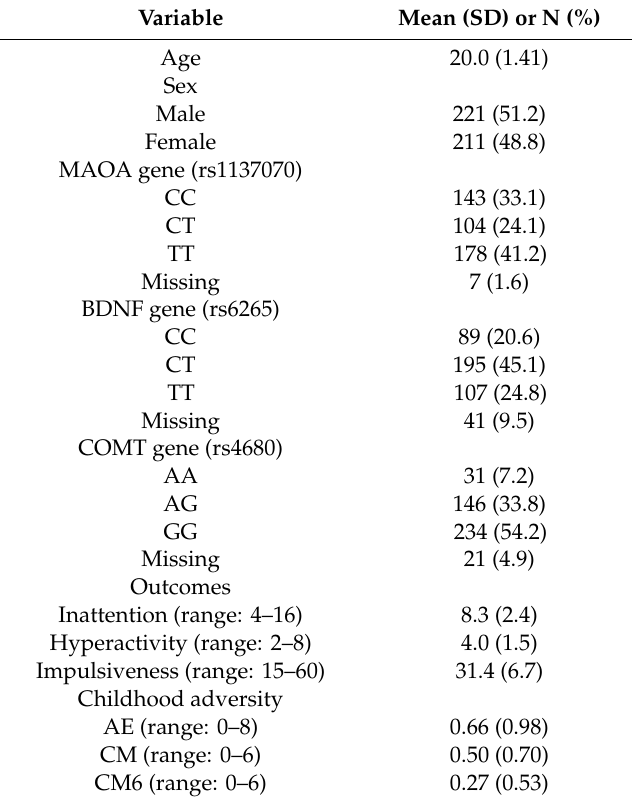
Table 1. Demographic information of participants (N = 432).